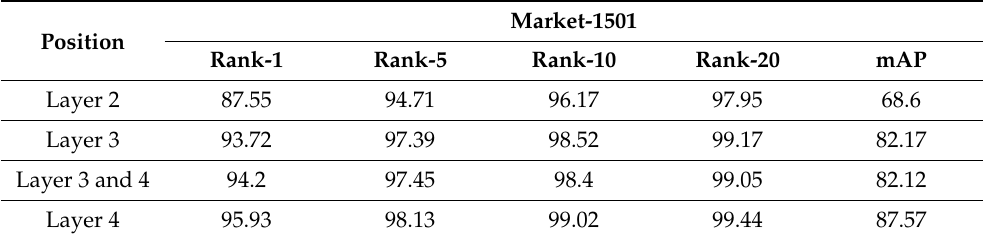
Table 8. Comparison of performance when changing attention